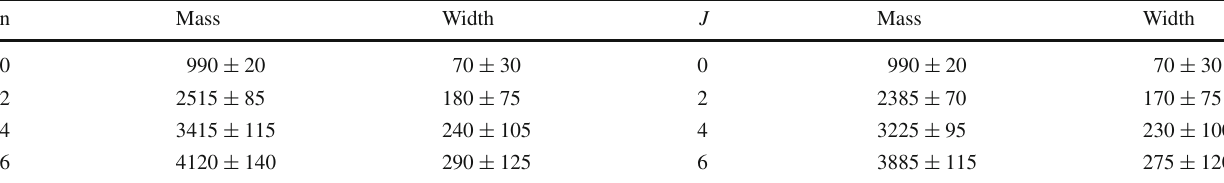
Table 6 Predictions using linear trajectories with glueball slope using f 0 ( 980 ) as the ground state